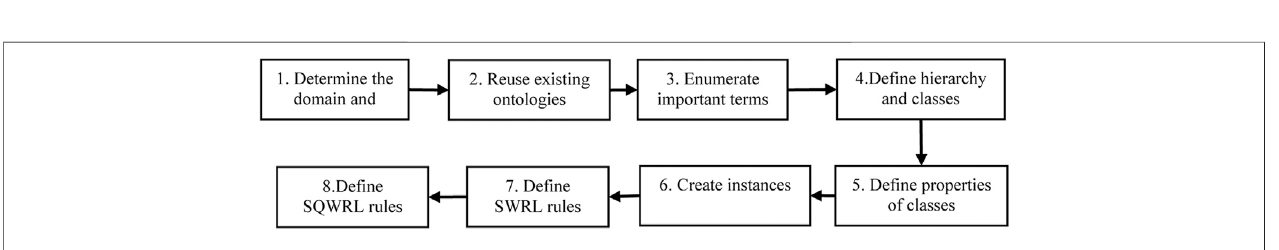
FIGURE 5 | Eight-step